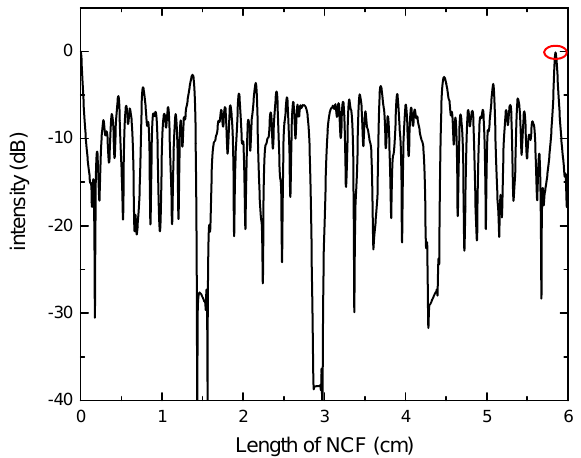
Figure 3. The power transmittance for different lengths of NCF (the minimum coupling loss is marked in the red circle).